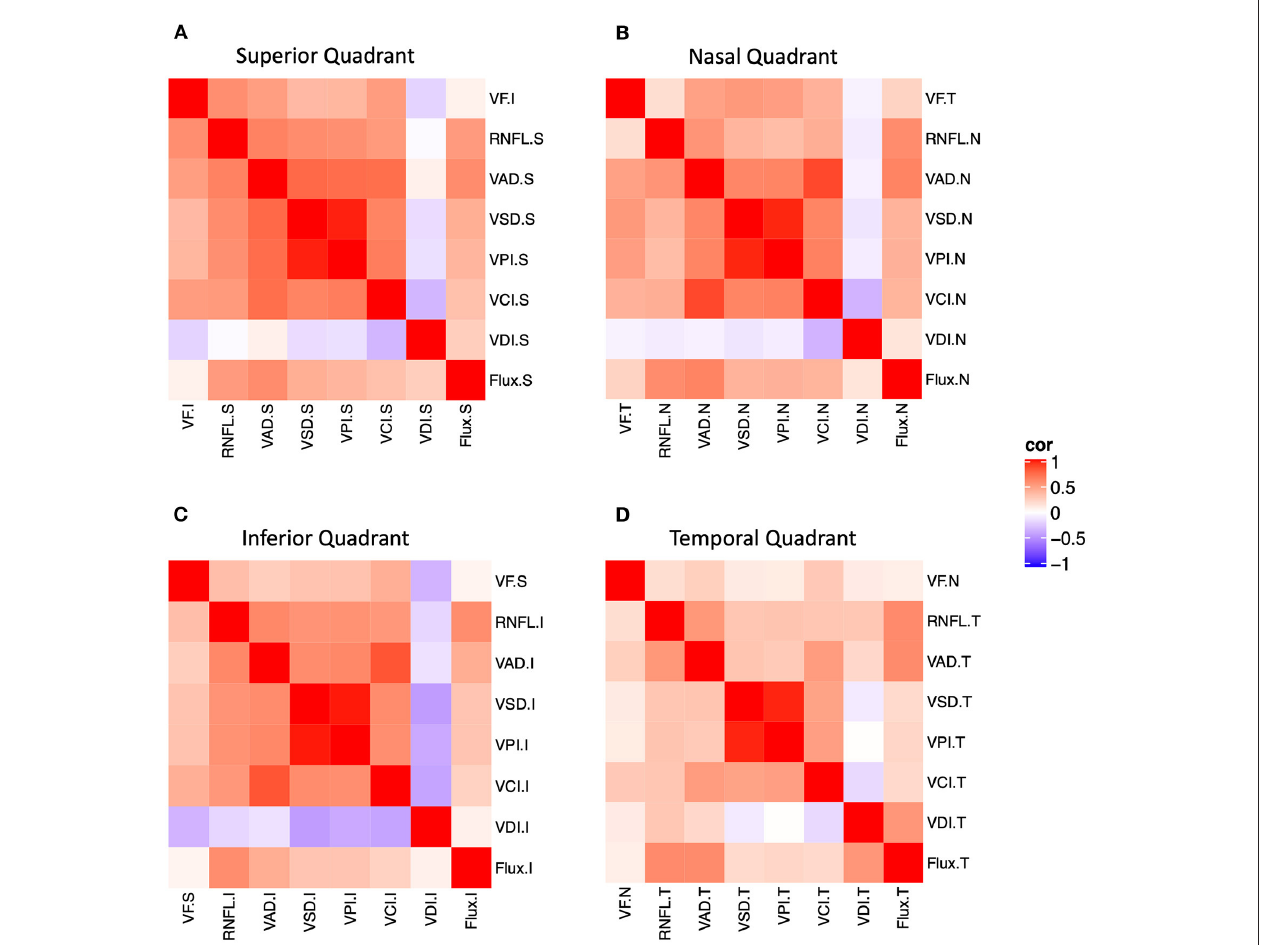
FIGURE 2 | Structure-function and structure-structure correlation matrix heatmap of static perimetry mean deviation and corresponding quadrant measurements of OCT RNFL and six peripapillary OCTA parameters in (A) superior, (B) nasal, (C) inferior, and (D) temporal quadrants. Note OCT/OCTA superior quadrant corresponds to the inferior visual field. S, superior quadrant; T, temporal quadrant; I, inferior quadrant, N, nasal quadrant. VAD, vessel area density; VCI, vessel complexity index, VDI, vessel diameter index; VPI, vessel perimeter index; VSD, vessel skeleton